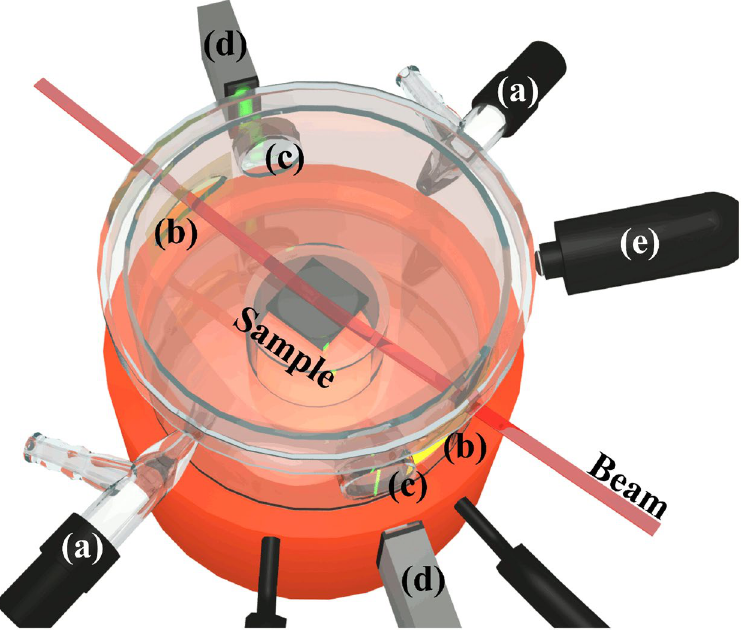
Figure 2. Illustration of the evaporation cell. Schematic outline of the evaporation cell used for the in-situ SAXS and GISAXS measurements. The cell is equipped with gas flow control ( a ), Kapton windows ( b ), glass windows ( c ), light band micrometer ( d ), and camera ( e